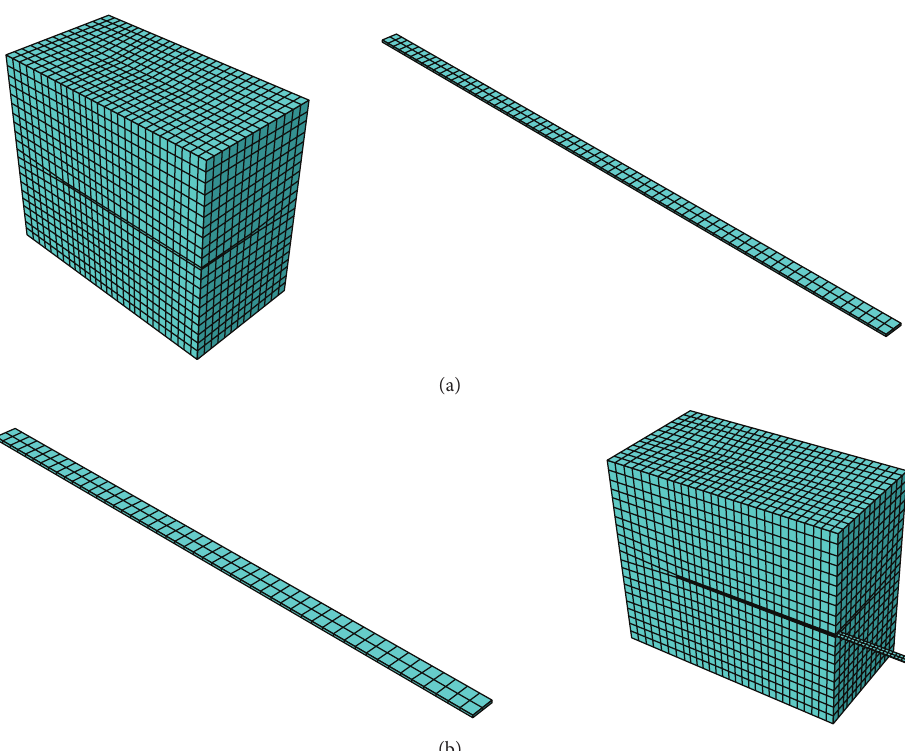
Figure 3: Mesh of concrete matrix, FRP plate, resin layer, and the reinforced concrete system.